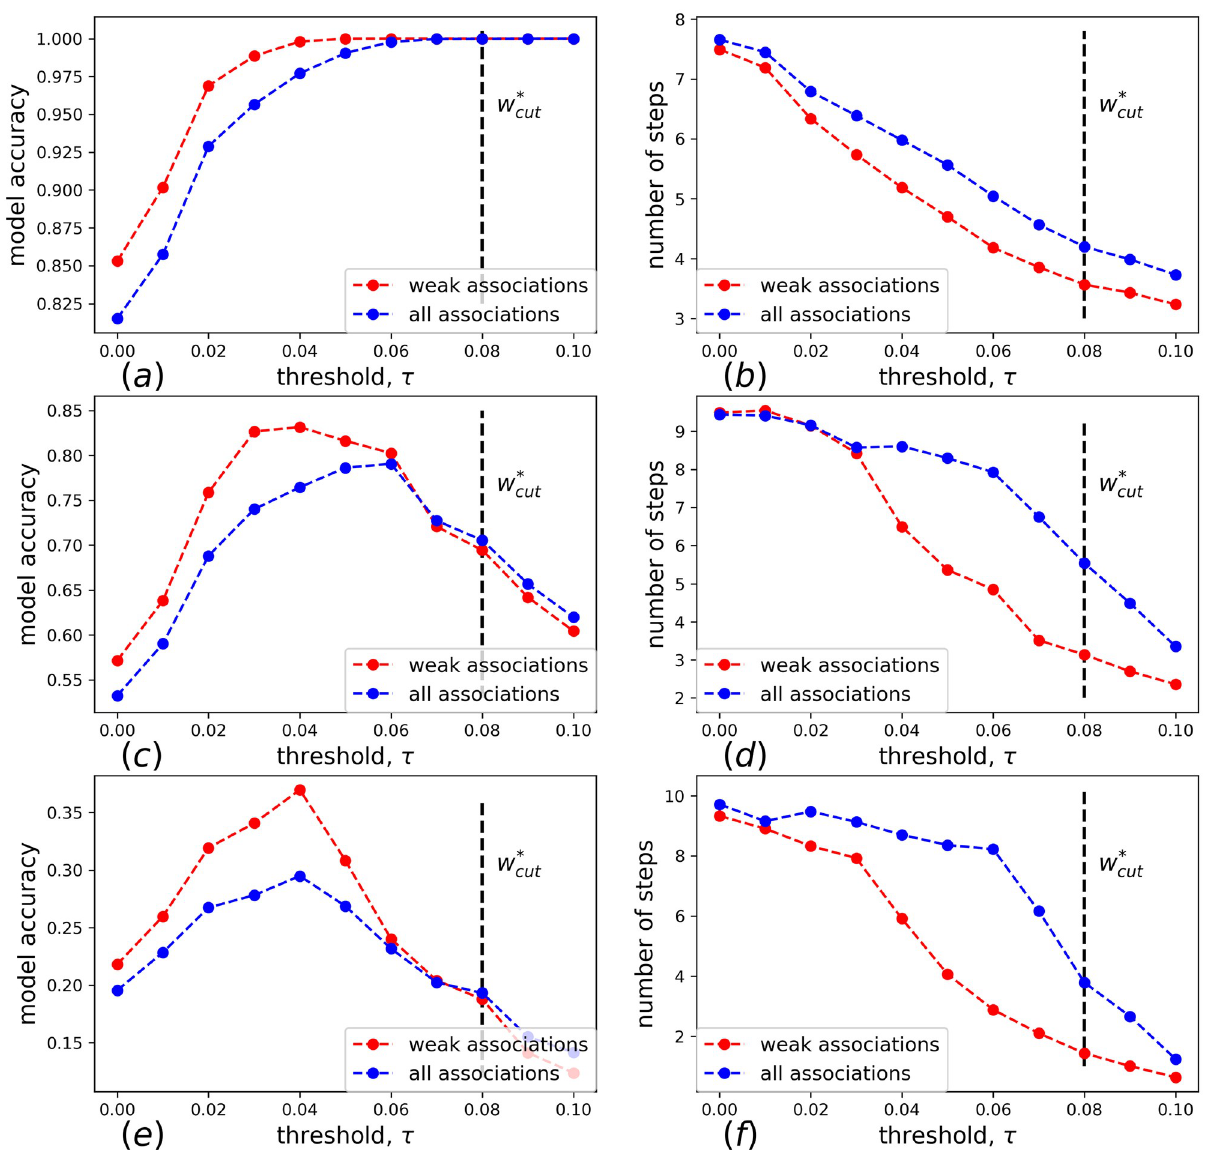
Fig 4. (a) The dependence of the model accuracy on the strength of the threshold τ for the RAT of different categories. The accuracy is calculated over 10 4 simulations and averaged over all RATs in a given hardness category. (b) The dependence of the mean length of solving trajectories on the threshold